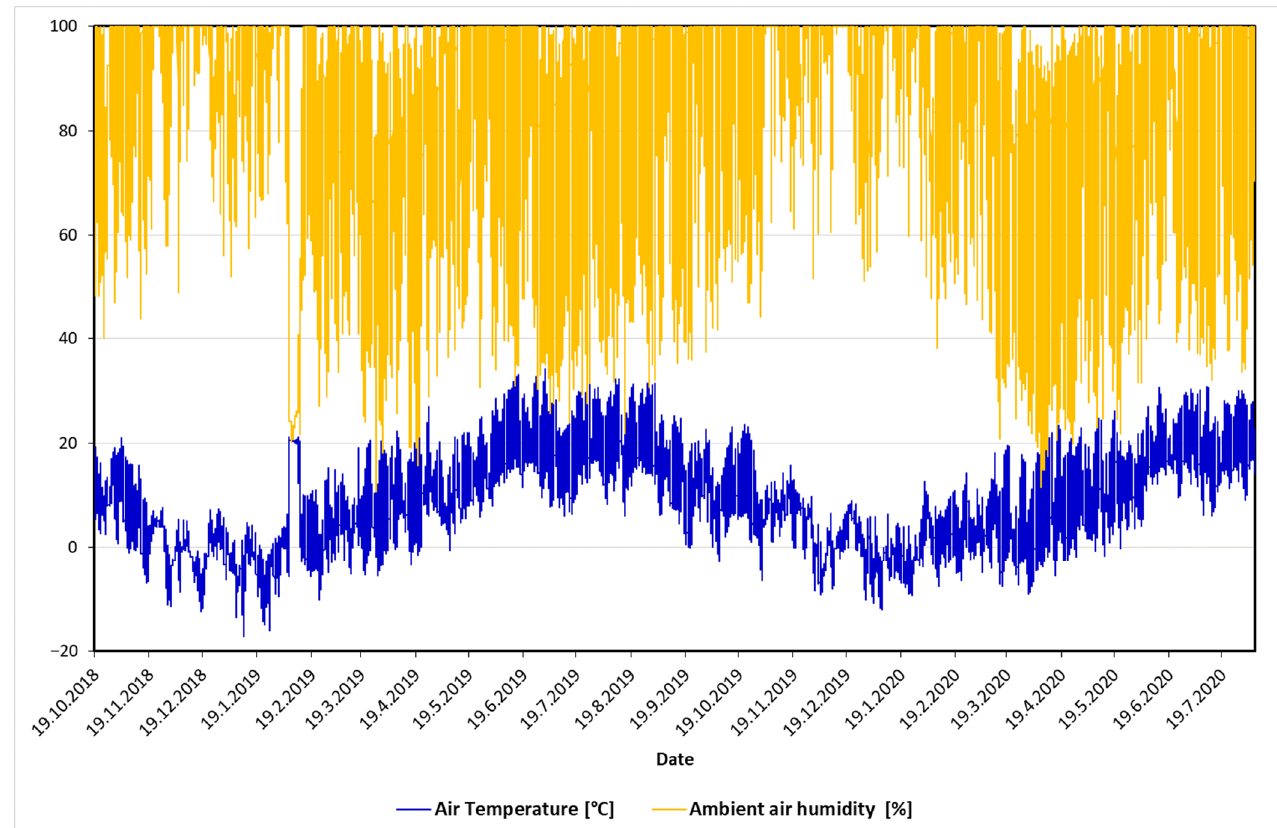
Figure 2. Ambient air humidity and air temperature during the storage